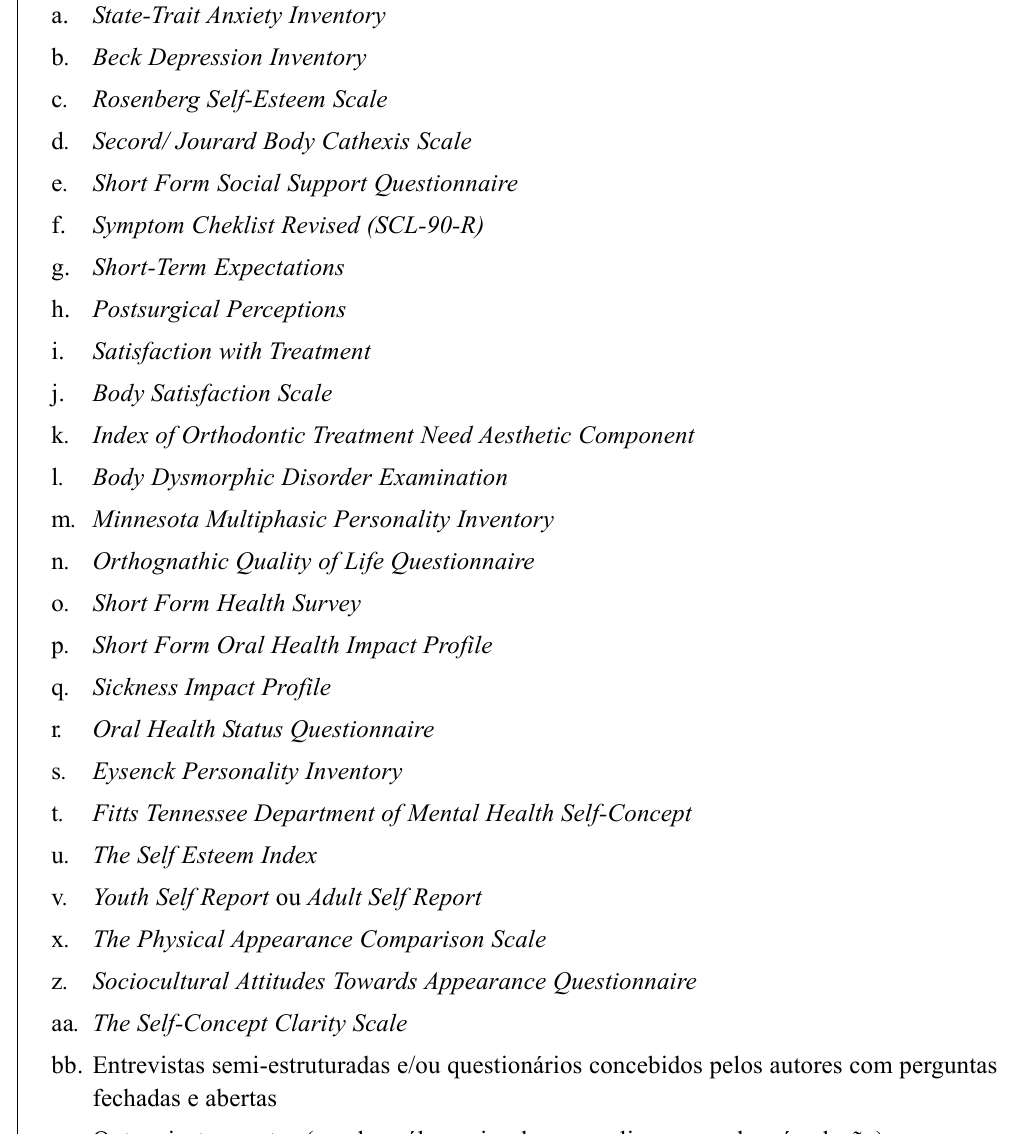
A devolução de questionários nunca atinge a taxa de 100%. Alguns participantes desistem de continuar com o tratamento, outros não foram encontrados, a posteriori , para preencher novamente os questionários, outros ainda não terminaram, na fase pós-operatória, o tratamento ortodôntico durante o período de recolha dos